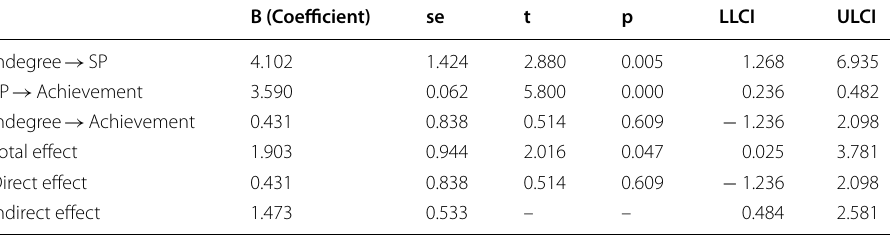
Table 8 The mediating effect of social presence on the relationship between indegree and perceived learning achievement